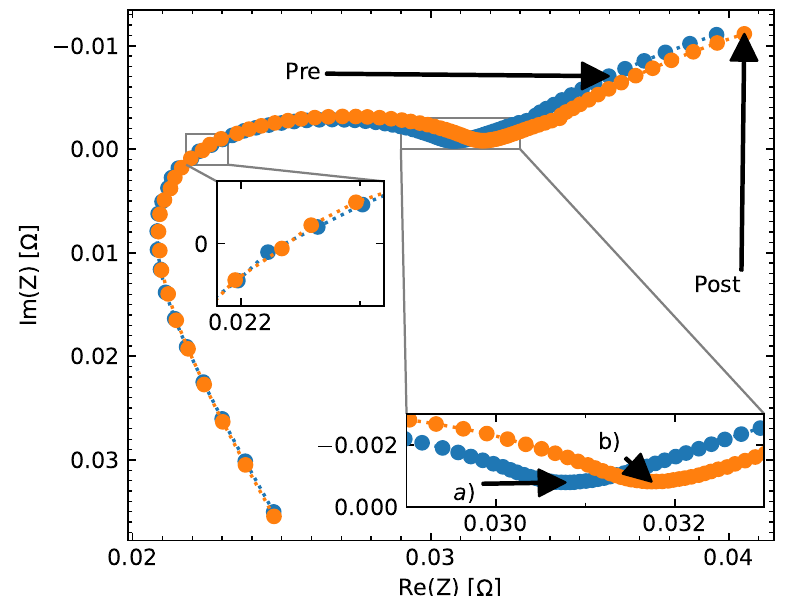
Figure 2. Nyquist plot of the EIS measurement carried out before (Pre) and after (Post) the LIBC was equipped with a temperature sensor. Point (a) and (b) compare the two high points of the first